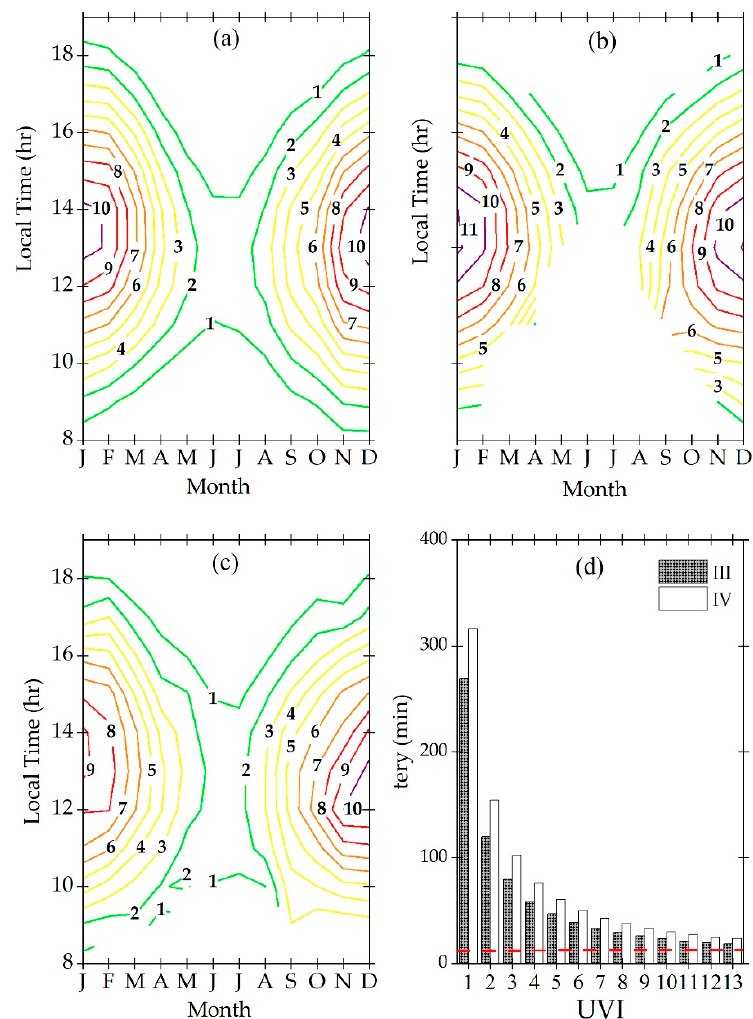
Figure 4. Contour plot of monthly average hourly values of the UV index (UVI) in Santiago for ( a ) all-sky, ( b ) clear, and ( c ) partially clear conditions, as well as ( d ) sunburn times in minutes for skin types III and IV, calculated during 2015–2019. The red dashed line in ( d ) represents t ery = 10 min. The colour scales (Violet ≥ 10; 8 ≤ red < 10, 6 < orange ≤ 7; 3 < yellow ≤ 5; green ≤ 2) in ( a )–( c ) correspond to the World Health Organisation (WHO) colour pattern [20].